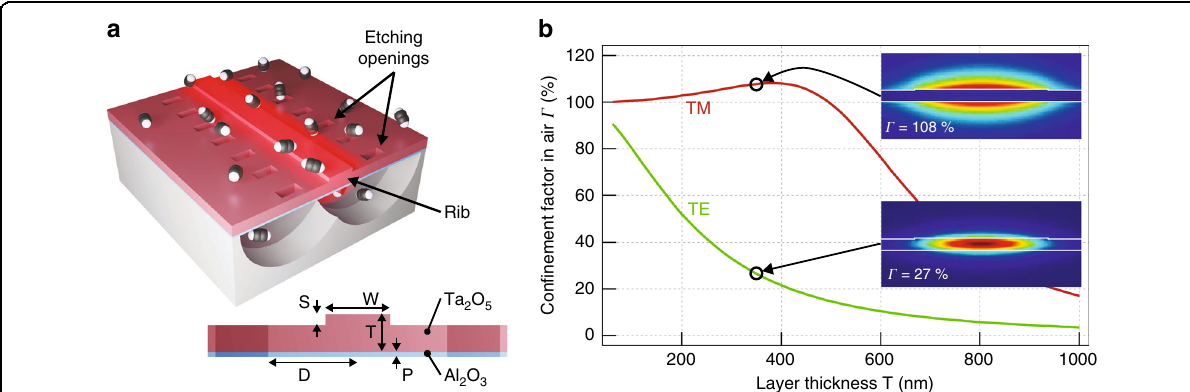
Fig. 1 Waveguide design with simulated evanescent fi eld con fi nement factor in air. a Schematics of the free-standing shallow rib waveguide interacting with C 2 H 2 molecules. The waveguide is patterned in a Ta 2 O 5 core layer, bottom-passivated by Al 2 O 3 . The membrane is underetched through the etching openings. Dimensions T = 350 nm, S = 30 nm, W = 4.5 µm, D = 25 µm, and P = 30 nm guarantee single-mode propagation at λ = 2.566 µm and negligible mode disturbance by the openings. b Simulated con fi nement factor in air versus Ta | E | 2 of the fundamental transversally magnetic (TM) and transversally electric (TE) mode fi eld distributions together with air con fi nement factors for the processed membrane thickness T = 350